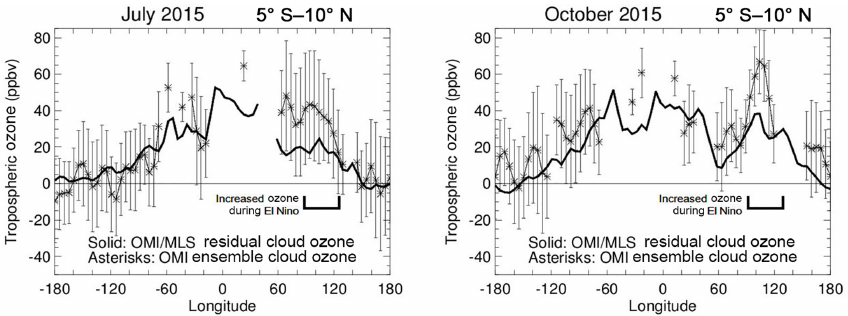
Figure 4. Comparisons of OMI/MLS (solid) and OMI ensemble (asterisks) cloud-ozone VMR for July and October 2015 with both months coinciding with the intense 2014–2016 El Niño event. Measurements are averaged over the 5 ◦ S–10 ◦ N latitude band as a function of longitude (at 5 ◦ increments). The ensemble measurements include calculated ± 2 σ uncertainties. Mean VMR for the ensemble measurements are calculated for all OCPs lying between 250 and 550hPa and radiative cloud fractions > 80%.